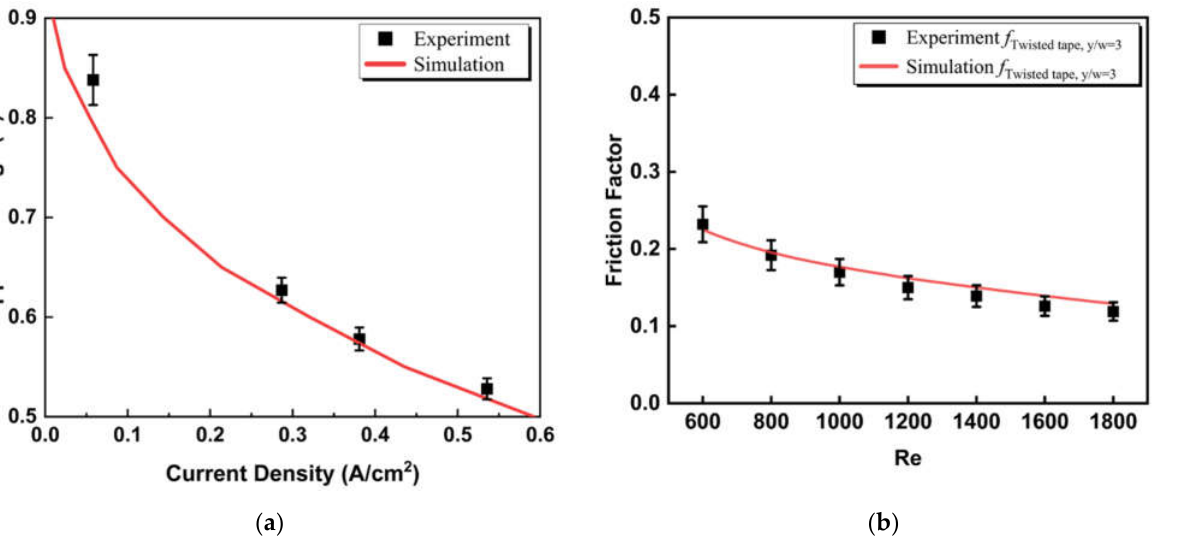
Figure 3. The comparison between ( a ) the applied voltage and current density of a micro-tubular SOFC, ( b ) friction factor as a function of Reynolds numbers from our simulation and the results from previous